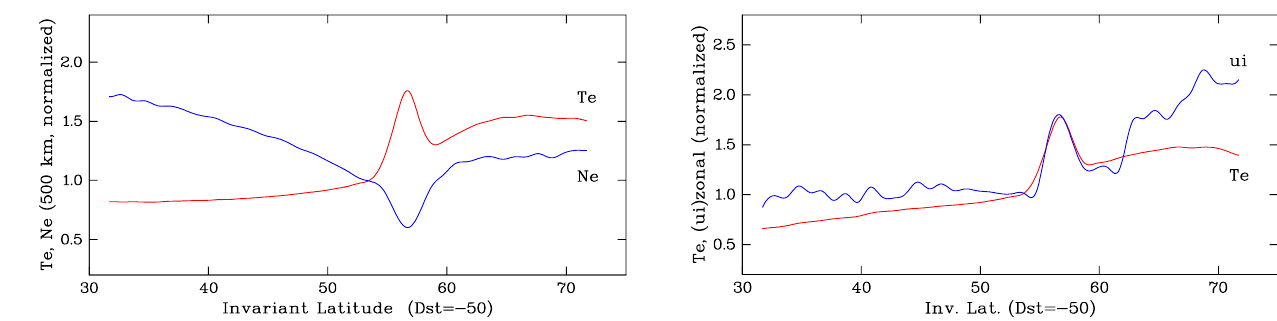
Fig. 13. Mean latitudinal profiles of the subauroral electron tem- perature enhancement (red line) and the associated electron density (blue line). The format of data presentation is similar to that of Fig. 12 except that this time both data sets have been normalized using temperature and density values measured at the equatorward boundary of the heating region, i.e. T e(latb) = T eb and Ne(latb) , respectively. Also, only the latitudinal variation of the median val- ues is shown. As before, all data have been adjusted to a common altitude of 500km, and only data collected in the height range 300 to 700km are considered. Again, the latitudes indicated on the ab- scissa refer to a Dst index of − 50nT.